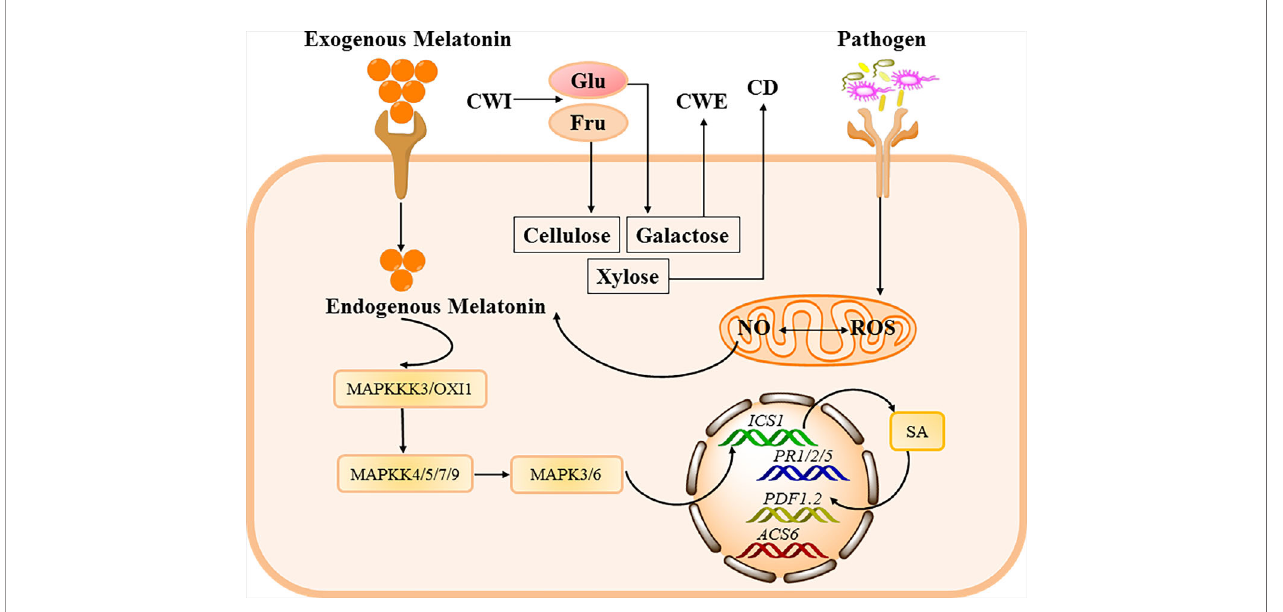
FIGURE 3 | The bacteriostatic mechanisms of melatonin in plants. Antibacterial mechanisms against plant pathogenic bacteria are characterized by up-regulation of defense genes such as plant defensin1.2 ( PDF1.2 ), plant resistance 1/2/5 ( PR1/2/5 ), and 1-aminocyclopropane-1-carboxylate synthase 6 ( ACS6 ) through several signal transduction pathways, including augmentation of NO levels in plants, which collaborates with melatonin in up-regulating SA. Moreover, melatonin can stimulate mitogen-activated protein kinases (MAPKs) cascades, which in turn up-regulate SA biosynthesis gene isochorismate synthase 1 ( ICS1 ). Additionally, high cell wall invertase (CWI) activity within melatonin-treated Arabidopsis leads to improved cell wall strengthening and callose-depositing factors (cellulose, xylose, and